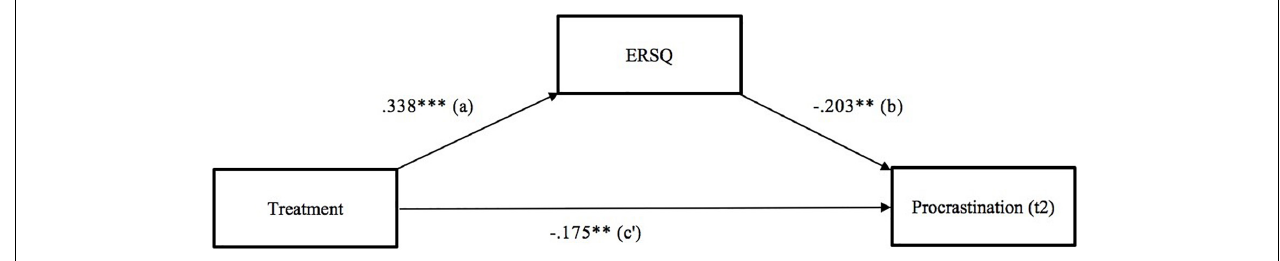
FIGURE 3 | Results of the mediation analysis with (cid:49) ERSQ as a mediator. Path analysis with unstandardized coefficients ( β ), according to Hayes (2018). All paths indicate significant effects. N = 148. ** p < 0.01; *** p < 0.001. a = path a, b = path b, c (cid:48) = path c (cid:48)